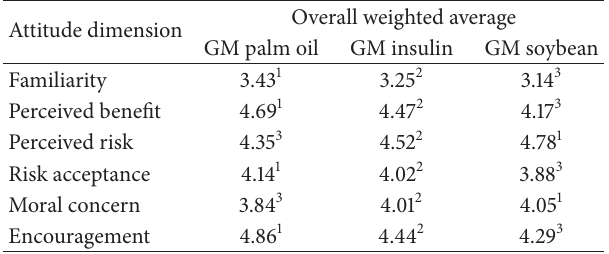
Table 10: Ranking of the three modern biotechnology applications. Overall weighted Attitude dimension